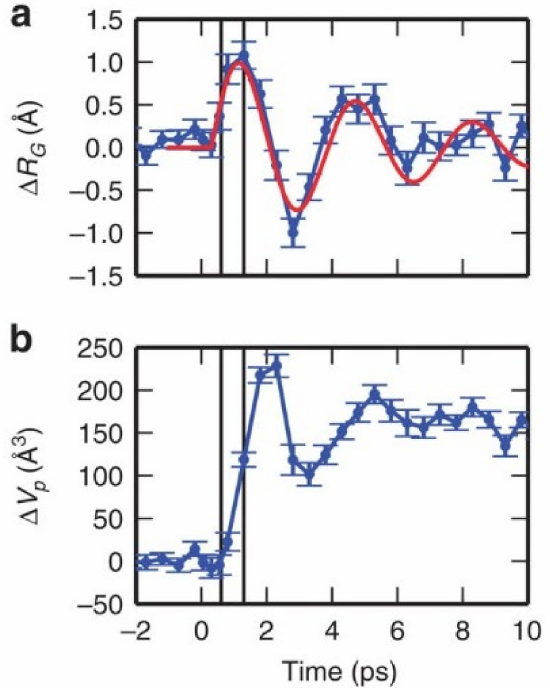
Figure 1. Time-dependent changes of protein structural parameters. Panel ( a ): radius of gyration; the red curve represents a damped oscillation with a 3.6ps time period and 6ps decay time. Panel ( b ): protein volume. Reproduced with changes from Ref. [53], under the Creative Commons CC BY 4.0